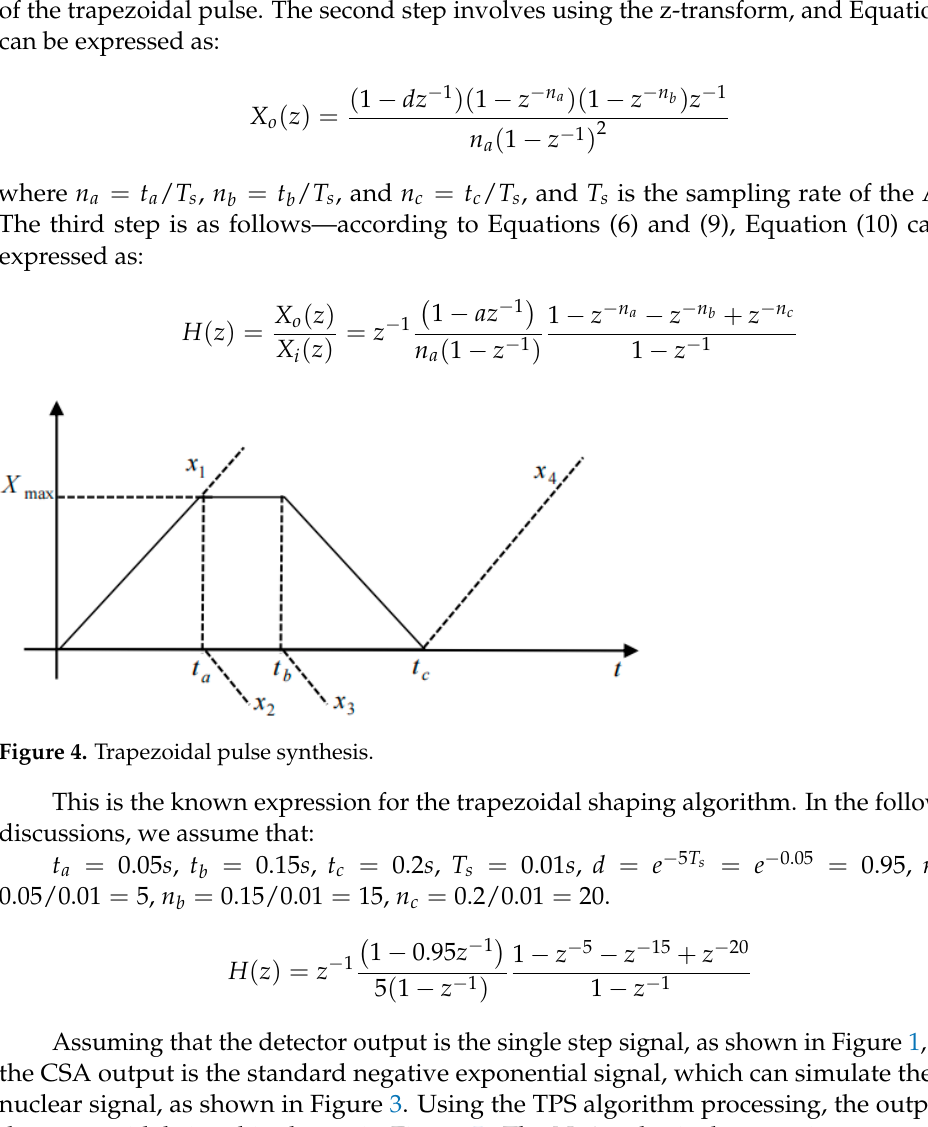
Figure 3. The typical CSA output.